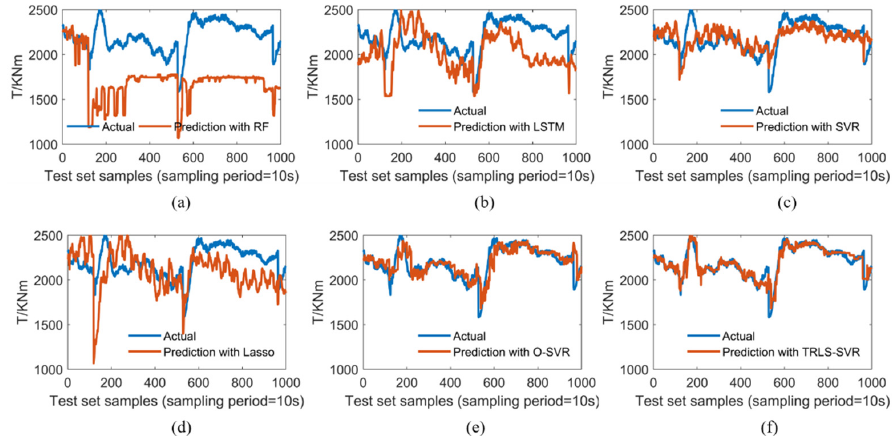
Figure 6. Comparisons between real and predicted cutterhead torque for dataset 2. ( a ) Prediction result of RF. ( b ) Prediction result of LSTM. ( c ) Prediction result of SVR. ( d ) Prediction result of Lasso. ( e ) Prediction result of OSVR. ( f ) Prediction result of TRLS-SVR.